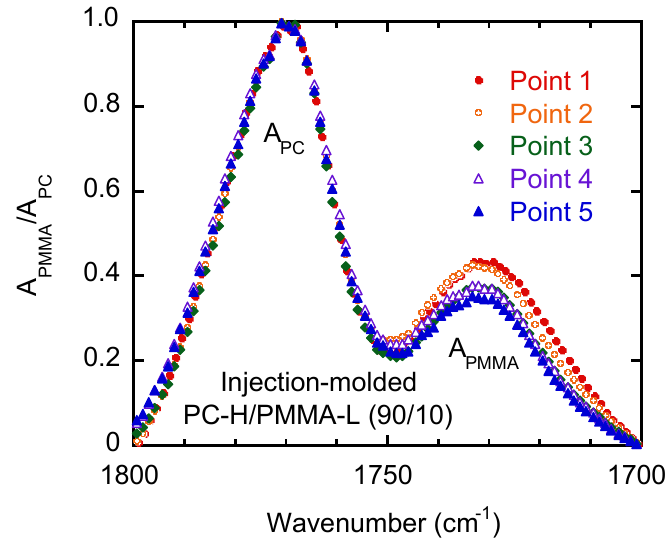
Figure 10. Normalized ATR-IR spectra at various positions of injection-molded PC-H/PMMA-L (90/10); (closed circles) point 1, (open circles) point 2, (diamonds) point 3, (open triangles) point 4, and (closed triangles) point 5.